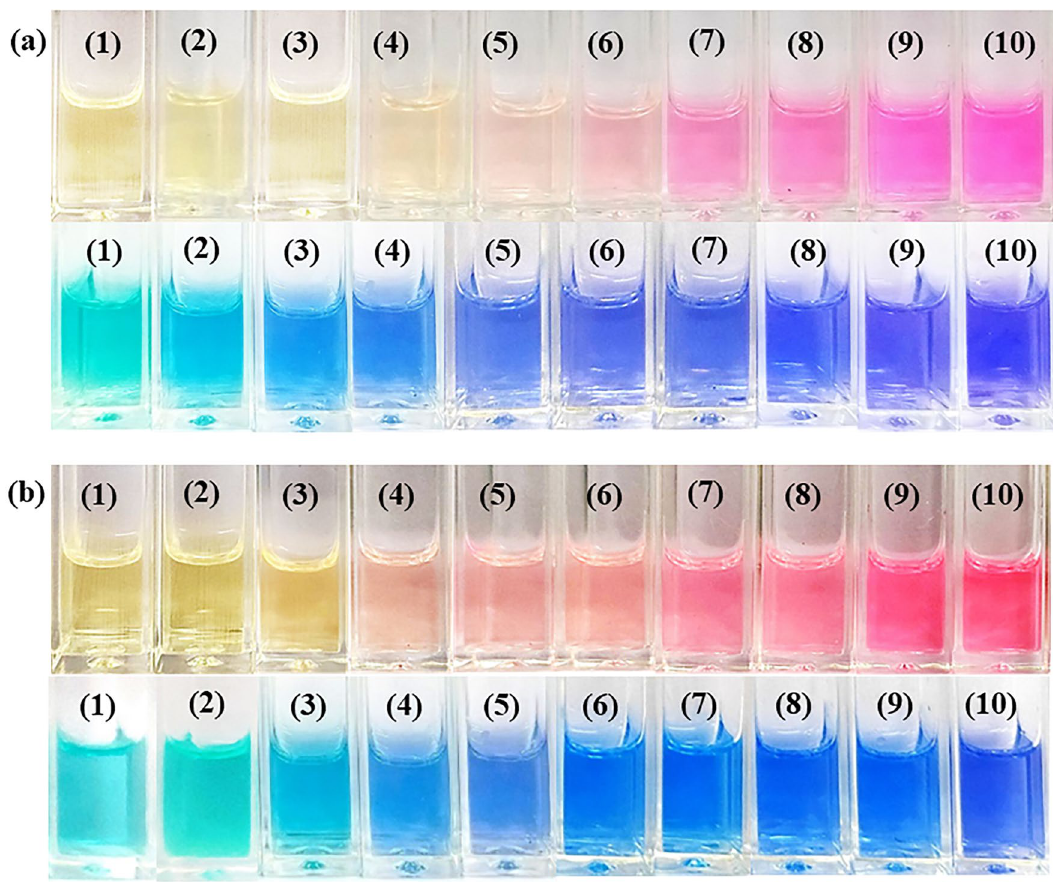
Figure 4. Change in color of the receptor L upon increasing concentration of Al 3+ ( a , Inset: concentrations 1 → 0 nM, 2 → 100 nM, 3 → 200 nM, 4 → 300 nM, 5 → 400 nM, 6 → 500 nM, 7 → 600 nM, 8 → 700 nM, 9 → 800 nM, 10 → 900 nM) and Fe 3+ ( b , Inset: concentrations 1 → 0 nM, 2 → 25 nM, 3 → 50 nM, 4 → 75 nM, 5 → 100 nM, 6 → 150 nM, 7 → 200 nM, 8 → 300 nM, 9 → 400 nM, 10 → 500 nM) in the top panel. Addition of equal proportion of methylene blue dye onto each test solution (bottom